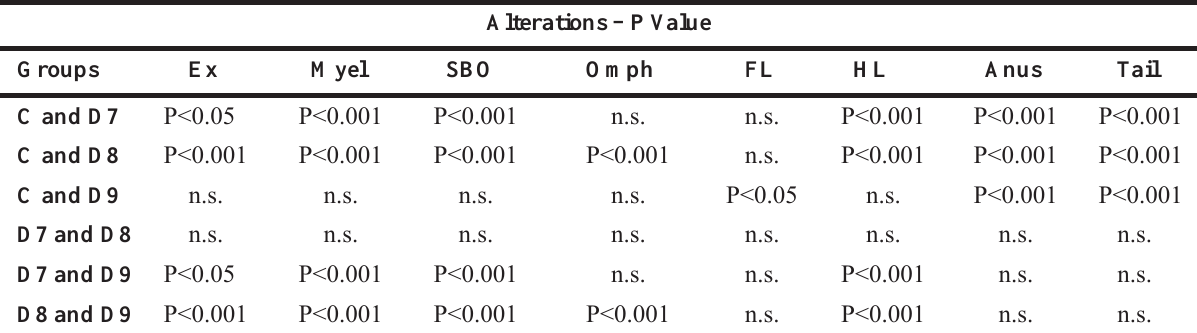
Table Y. C = control, D = gestational day, Ex = exencephaly, Myel = myelomeningocele, SBO = spina bi fi da occulta, Gas = gastroschisis, Omph = omphalocele, FL = alterations of the forelimbs, HL = alterations of the hindlimbs. n.s. = non-signi fi